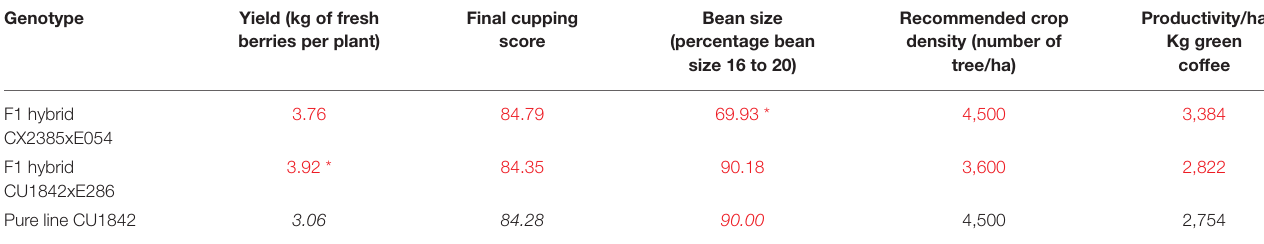
Pure line CU1842 84.28 90.00 2,754 Comparison of the target traits. Numbers in italics indicate the selection threshold. Numbers in red indicate the performances obtained in the shade trial. Numbers in black indicate performances obtained in the sun trial. Means followed by an asterisk indicate a difference between the pure line CU1842 and the F1 hybrid according to the non-parametric Wilcoxon rank-sum